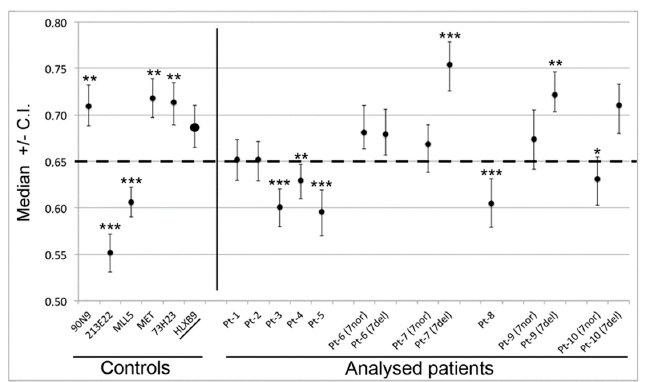
Figure 6. Radial nuclear location (RNL) of the HLXB9 locus in del(7q) patients. The graph displays median value and relative confidence interval (C.I.) corresponding to the RNL of the HLXB9 locus in patients and controls. On the left are the RNL of the genomic loci 90N9 (7q21.11), 213E22 (7q22.1), KMT2E (7q22.3), MET (7q31.2), 73H23 (7q34) and HLXB9 in nuclei of control cells (lymphocytes from peripheral blood of volunteer healthy donors from [10]). On the right side, each RNL value refers to the HLXB9 gene in the indicated patients (Pt-1 to Pt-10). For Pt-6, Pt-7, Pt-9, and Pt-10 the two alleles were measured separately: 7nor and 7del indicate HLXB9 in the normal or deleted chromosome 7, respectively. In the other cases, the RNL value refers to both HLXB9 alleles, as it was not possible to discriminate between the two, due to a low number of informative nuclei. The dashed line at 0.65 indicates the median value separating the peripheral and the internal nuclear compartment, i.e. values higher than 0.65 are peripheral, and values lower than 0.65 are internal to the nucleus. Statistical significance of the difference in the RNL data obtained for each probe with respect to the HLXB9 in the control cells (name underlined, and RNL indicated by an enlarged spot), was evaluated using the two-tailed t tests. p values are: * p <0.05, ** p <0.001, *** p <0.0001.